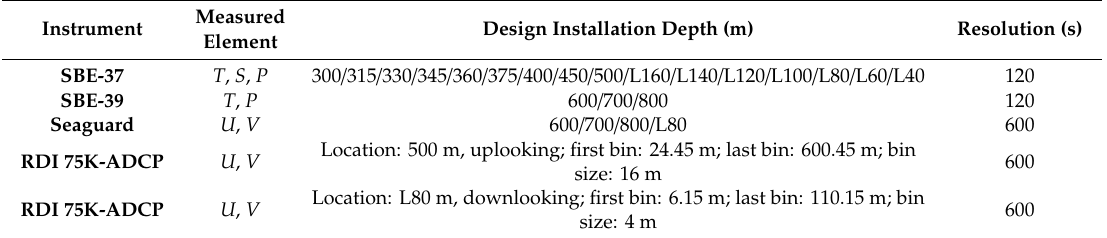
Table 3. Observation instruments and measured elements at Mooring 2